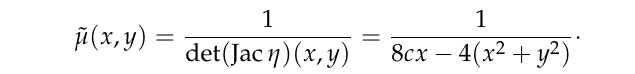
Figure 1. The elliptic umbilic caustic surface in three-dimensional parameter space s 1 , s 2 are source plane coordinates and c is the central point shown. A c -slice of this caustic is shown in Figure